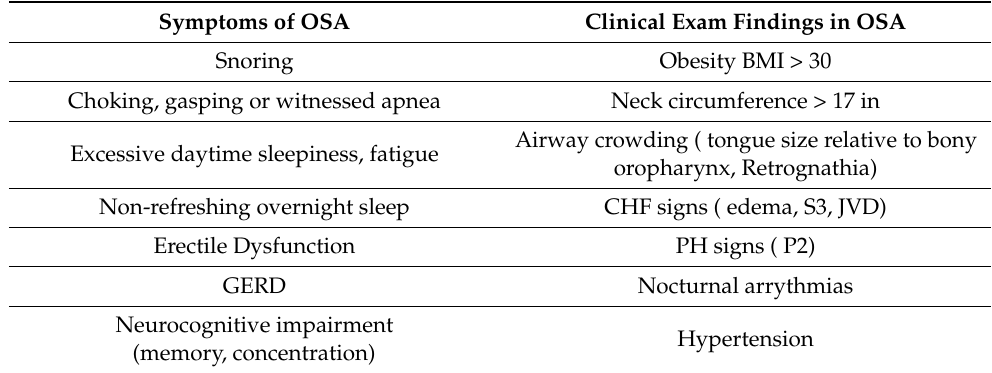
Table 1. Symptoms and signs of OSA